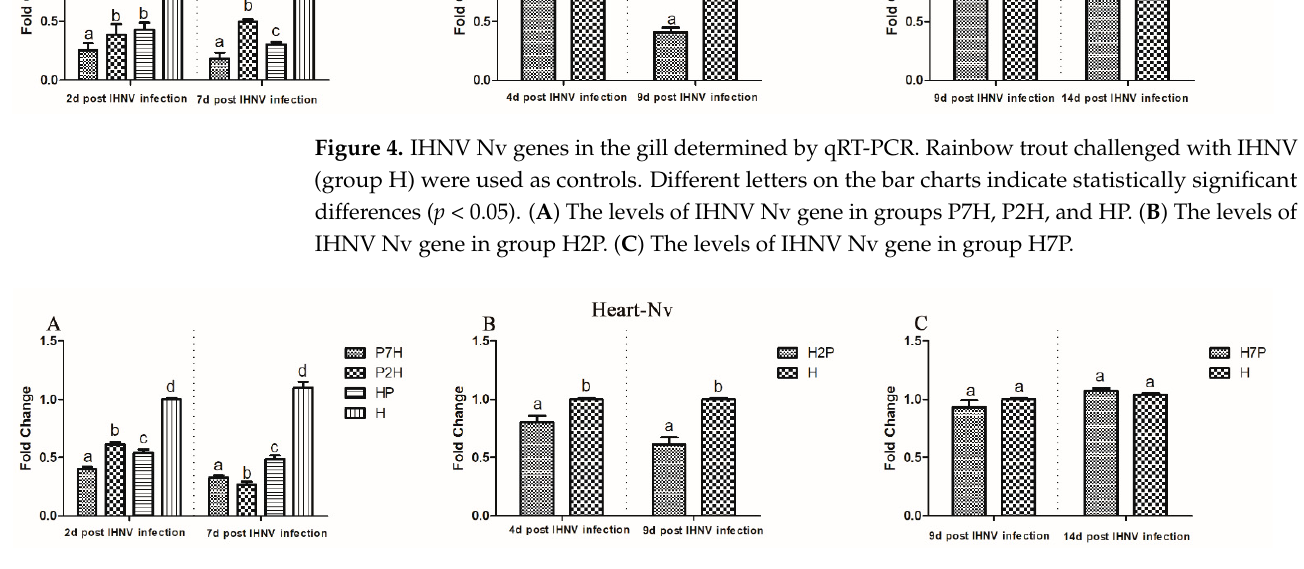
Figure 5. IHNV Nv genes in the heart determined by qRT-PCR. Rainbow trout challenged with IHNV (group H) were used as controls. Different letters on the bar charts indicate statistically significant differences ( p < 0.05). ( A ) The levels of IHNV Nv gene in groups P7H, P2H, and HP. ( B ) The levels of IHNV Nv gene in group H2P. ( C ) The levels of IHNV Nv gene in group H7P.